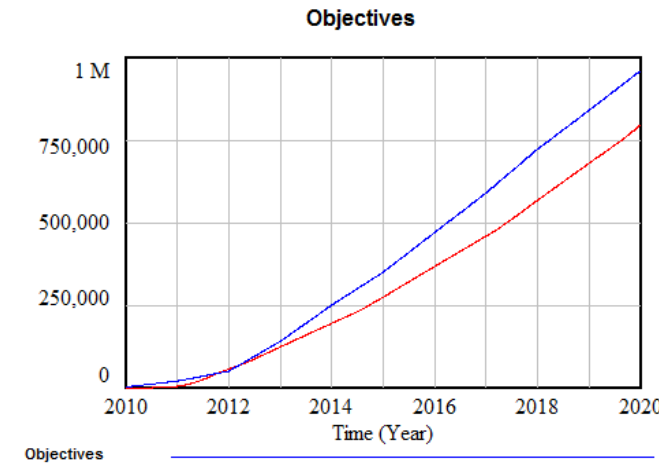
Figure 14. Electric vehicle fleet compared to the Government target for the optimistic scenario without subsidies in 2013 (the authors’